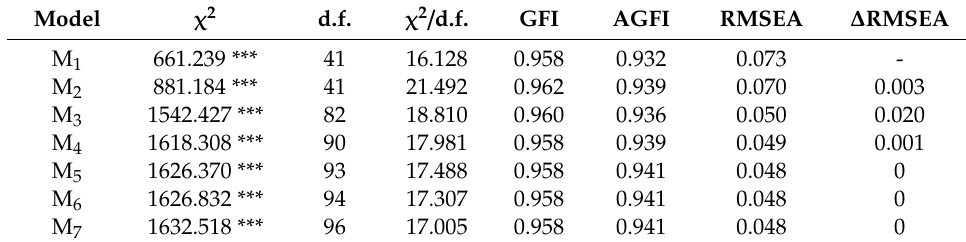
Table 4. Multi-group Model Invariance